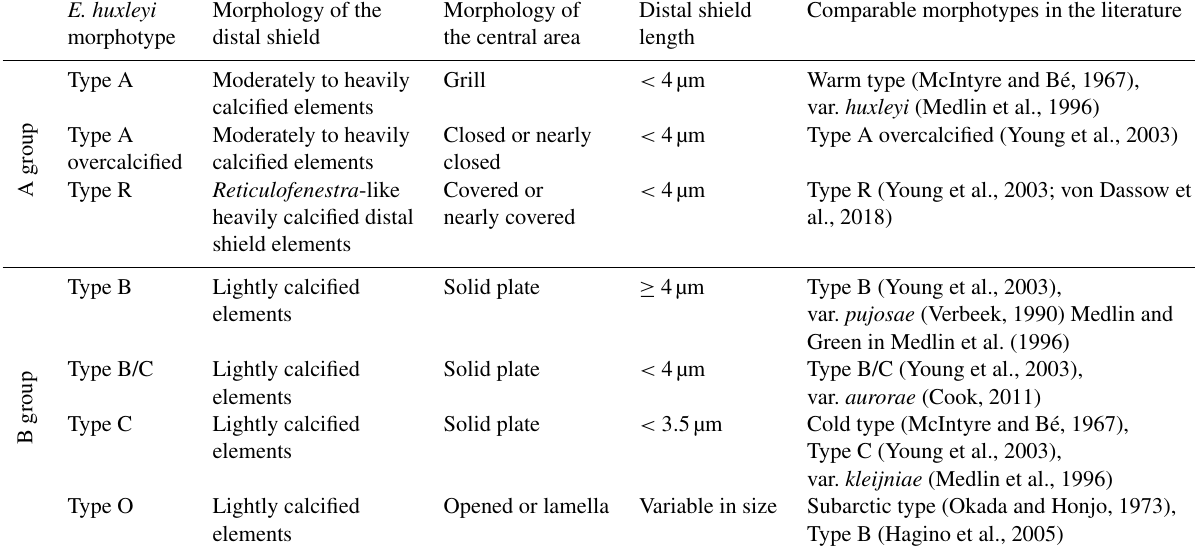
Table 1. Classification scheme of Emiliania huxleyi morphotypes observed in the present study (modified from Hagino et al., 2011, following Young and Westbroek, 1991, Cook et al., 2011, and Young et al., 2019). Morphology of the Morphology of Distal shield Comparable morphotypes in the